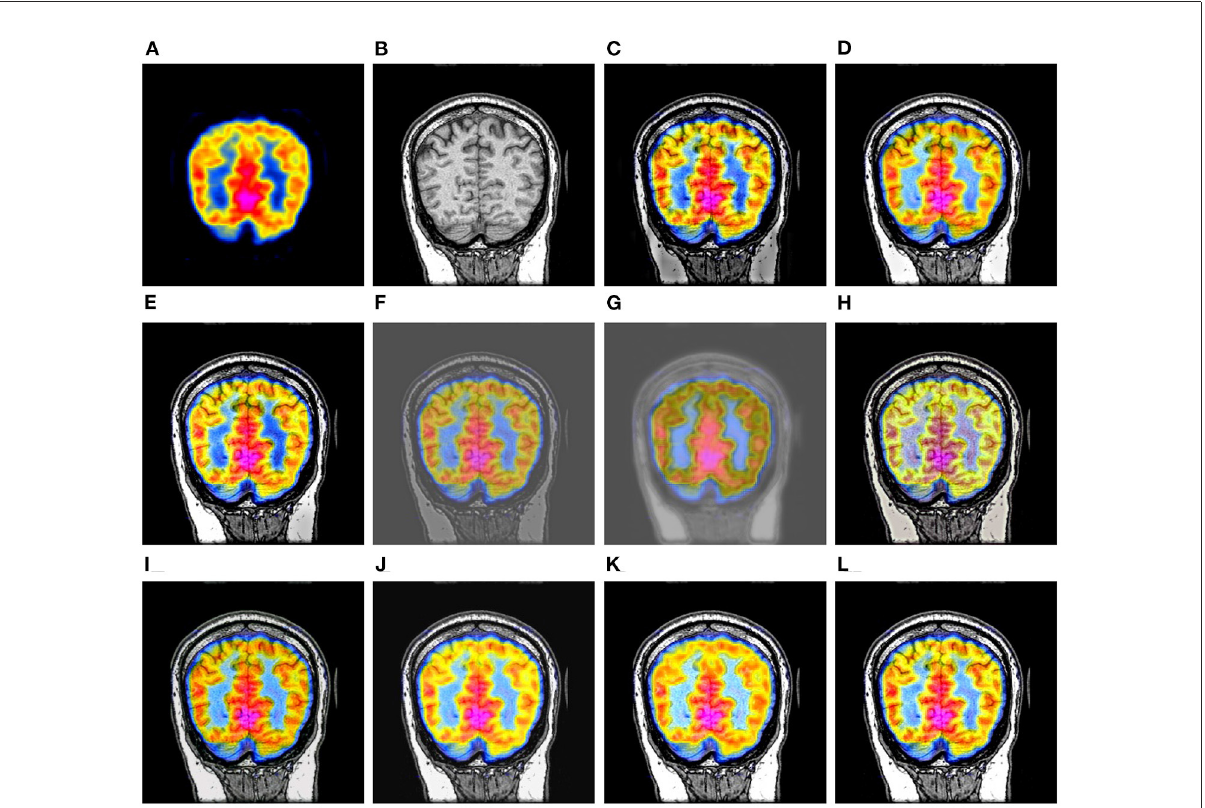
Figure 7C that the intensities of the bottom part of DWT’s fusion image are significantly lower than that of the original MR